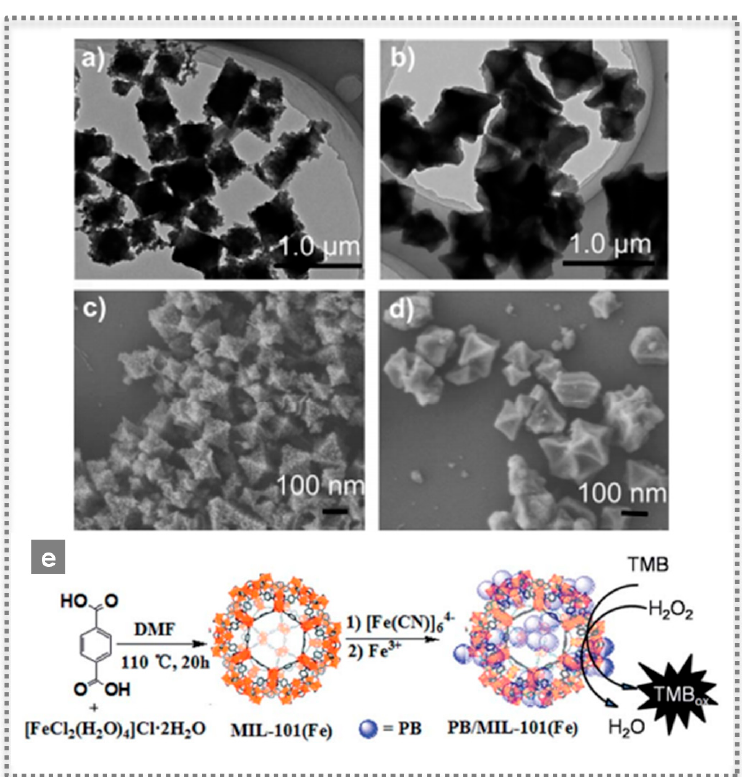
Figure 4. Characterization by TEM ( a , b ) and SEM ( c , d ) of microporous MOF MIL-101(Fe) as-prepared ( a , c ) and after introducing Prussian blue, PB/MIL-101(Fe) ( b , d ), as highly efficient peroxidase-like mimics, and scheme illustrating the synthesis of PB/MIL-101(Fe) ( e ) (Reproduced with permission [23] Copyright 2015, The Royal Society of Chemistry).